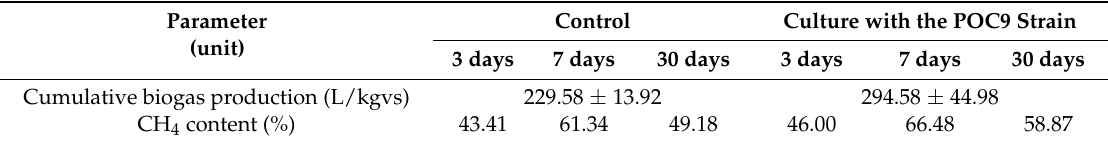
Table 2. Cumulative biogas production and methane content in biogas of control and POC9- supplemented variants of the experiment simulating anaerobic digestion of sewage sludge.